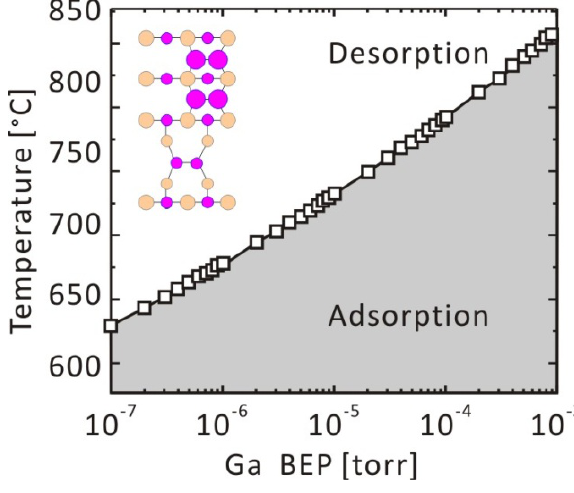
Figure 4. Pressure-temperature phase diagram for the GaAs(001)-(4 × 2) β 2